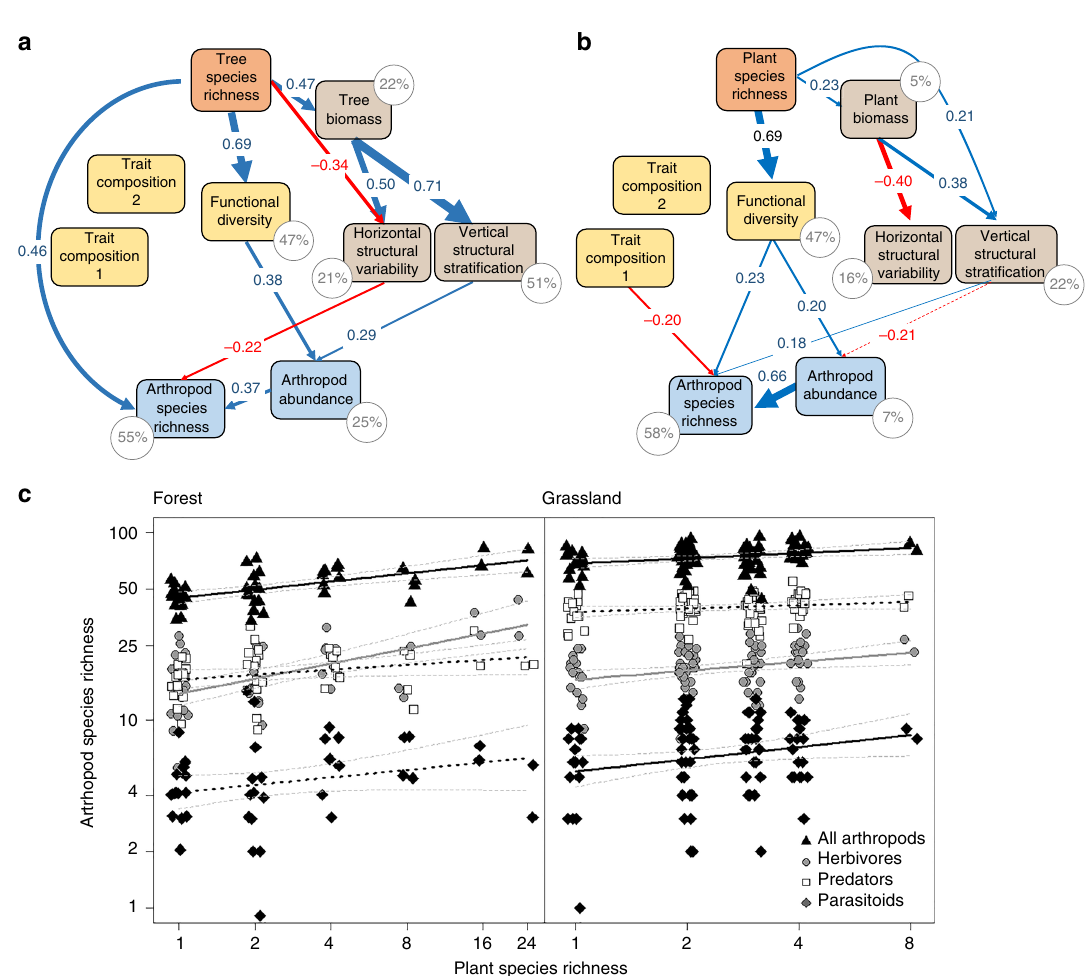
Fig. 1 Effects of plant diversity on arthropod species richness. Direct and indirect effects of plant species richness (orange), leaf trait functional diversity and composition (yellow), and structural characteristics (brown) of the plant communities on overall arthropod abundance and species richness (blue) for a the forest system ( χ 2 = 6.96, DF = 10, P = 0.789), and b the grassland system ( χ 2 = 19.9, DF = 14, P = 0.185) based on path model results. Trait compositions 1 and 2 represent the fi rst two axes of a principal components analysis (PCA) on community-weighted means of fi ve leaf traits; functional diversity is the mean pairwise dissimilarity (based on Rao ’ s Q ) of these traits among study plots. Vertical strati fi cation (based on Rao ’ s Q ) and horizontal variability of plant structure (based on Moran ’ s I ) represent variability in plant height (grassland) or the fi rst two axes of a PCA on the variability of tree height and crown projection area (forest) within the study plots. Positive and negative pathways and their corresponding standardized path coef fi cients in a and b are indicated in blue and red, respectively. Solid lines show signi fi cant relationships ( P ≤ 0.05 based on 1000 bootstrap draws; scaled by their standardized effect size), dotted lines show non-signi fi cant pathways (see Supplementary Tables 2, 3 for full results). For clarity, covariances between structural and functional diversity (see Fig. S4) were not plotted but are shown in Supplementary Tables 2 and 3. Percentage values show the explained variance of endogenous (dependent) variables. Effects of plant species richness on arthropod species richness c in the BEF-China forest experiment (left panel; values corrected for the number of trees sampled; N = 46 study plots), and in the Jena Experiment in grassland (right panel; N = 92). Solid regression lines indicate signi fi cant ( P < 0.05) relationships, broken regression lines show marginally signi fi cant relationships ( P < 0.1). Broken gray lines are 95% con fi dence intervals. Source data are provided as a Source Data fi